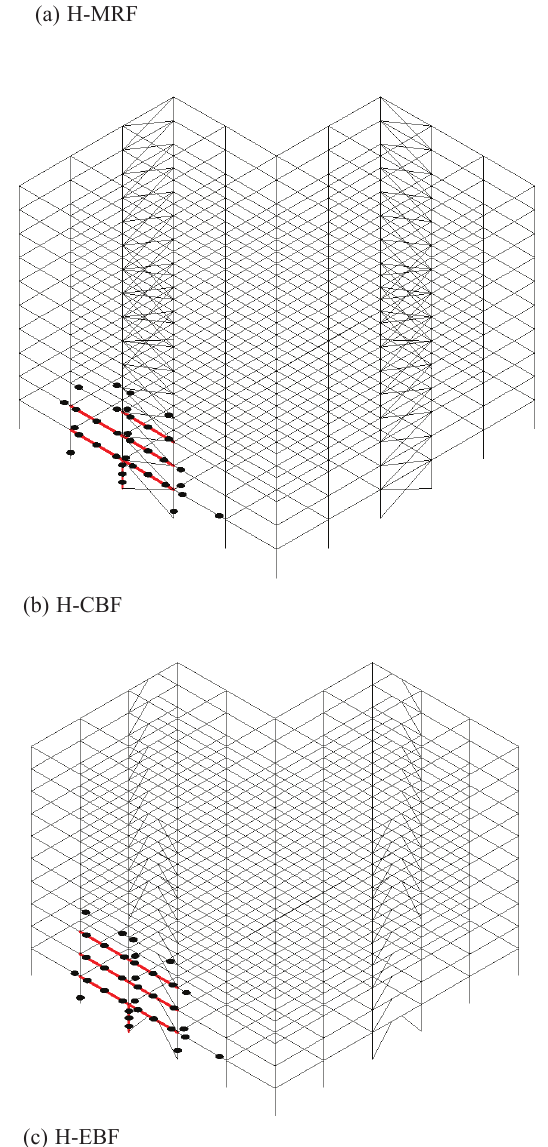
Fig. 5. Member failure and plastic hinge locations for horizontally irregular MRF, CBF, EBF – Blast Location 1